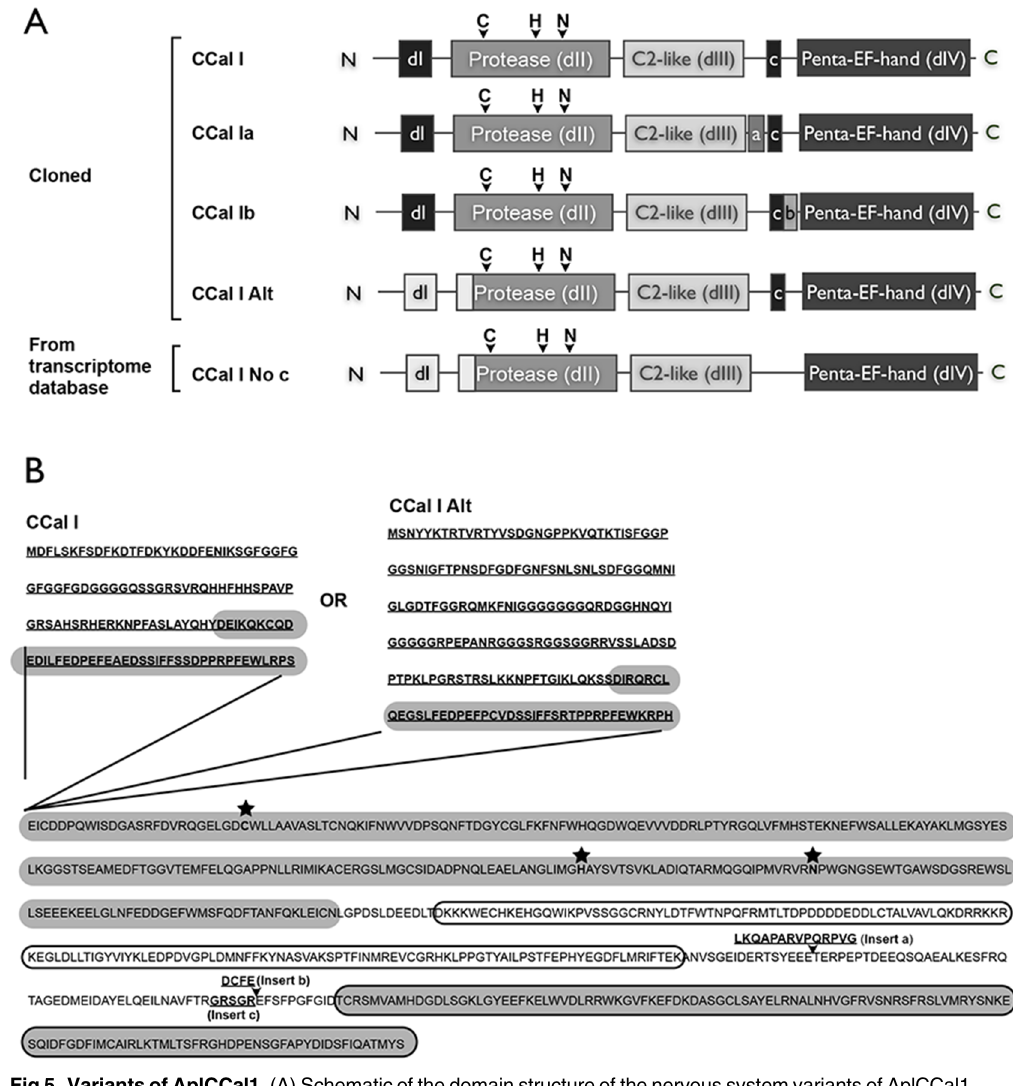
Fig 5. Variants of AplCCal1. (A) Schematicof the domain structure of the nervous system variants of AplCCal1. Spliceinserts a, b, and c, and the alternativeN-terminiare indicatedby shaded blocks. The known calpaindomains are shown. The positionsof the catalytic triad: cysteine(C), histidine(H) and asparagine(N) are shown. (B) Amino acid sequenceof the AplCCal1variants. Splice inserts a, b, and c, and the alternative N-termini are indicated. The catalytic residues are marked with stars. Domains (catalytic (shaded), C2L (outlined),PEF (outlinedand shaded)) are shownin ovals. Note that the catalytic domainstarts in the alternativeN-terminal exons.